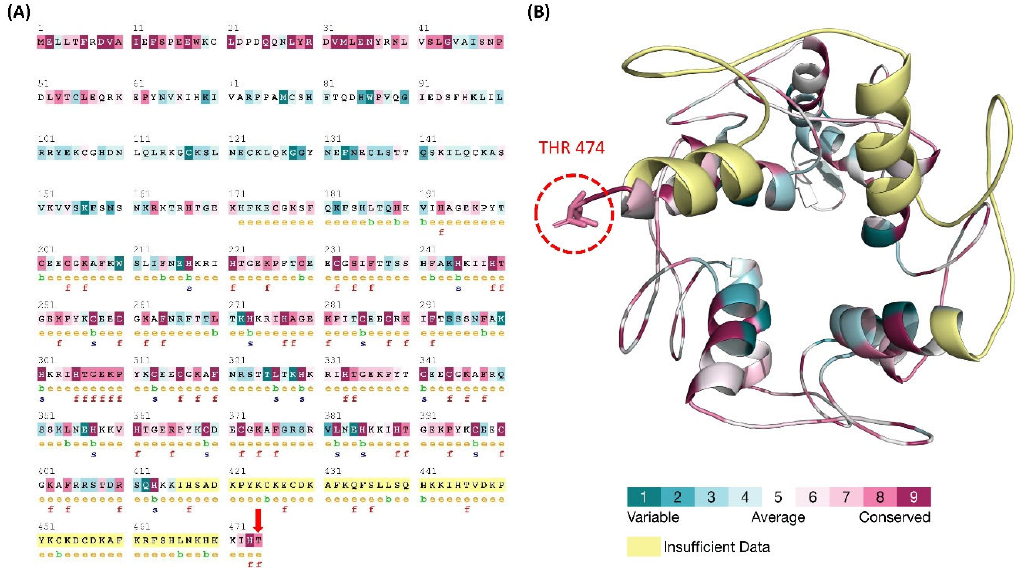
Figure 2. ConSurf Conservation analysis of each residue of the ZNF141 protein to show the conser ‐ vation score. ( A ) Conservation score and structural and functional impact classification of each res ‐ idue of the ZNF141 protein. ( B ) Cartoon representation of the ZNF141 protein in line with the color code of the conservation